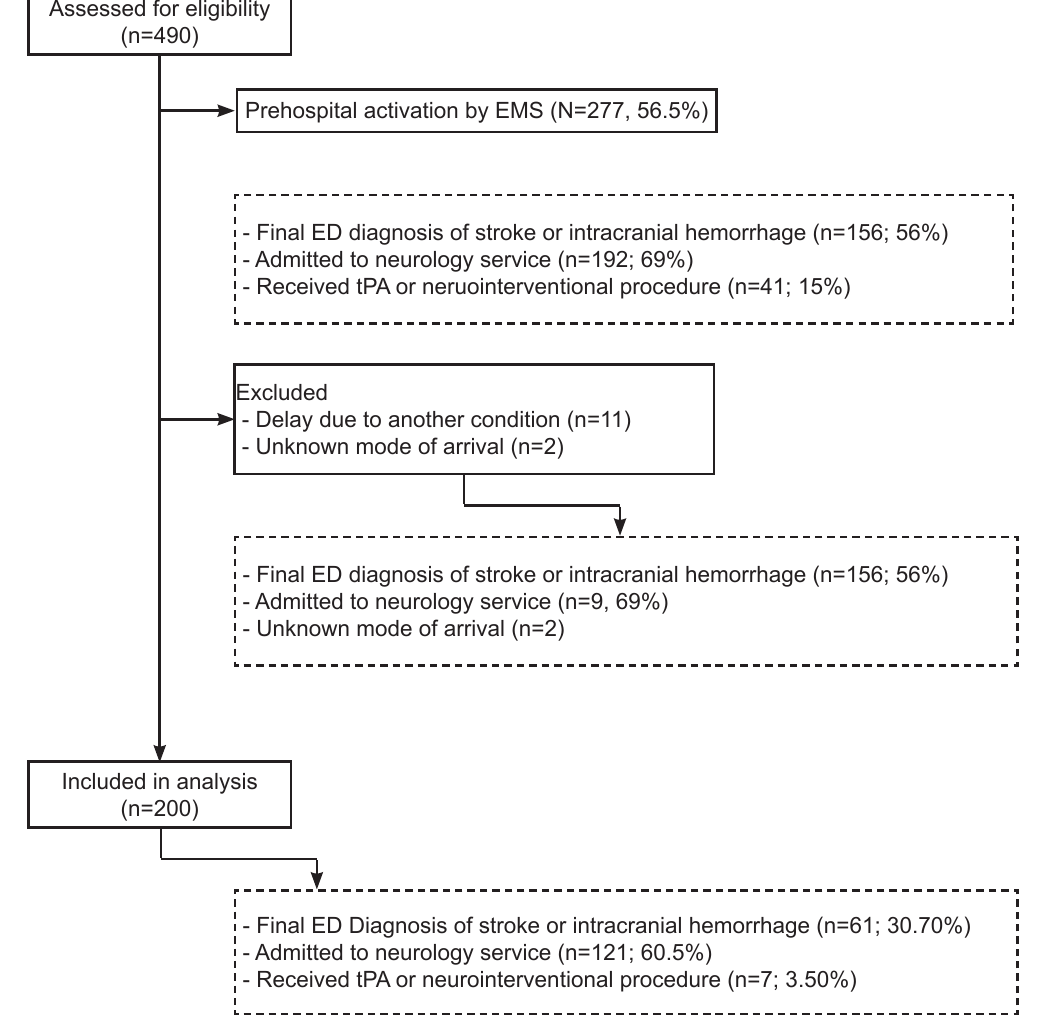
Figure. Study flow